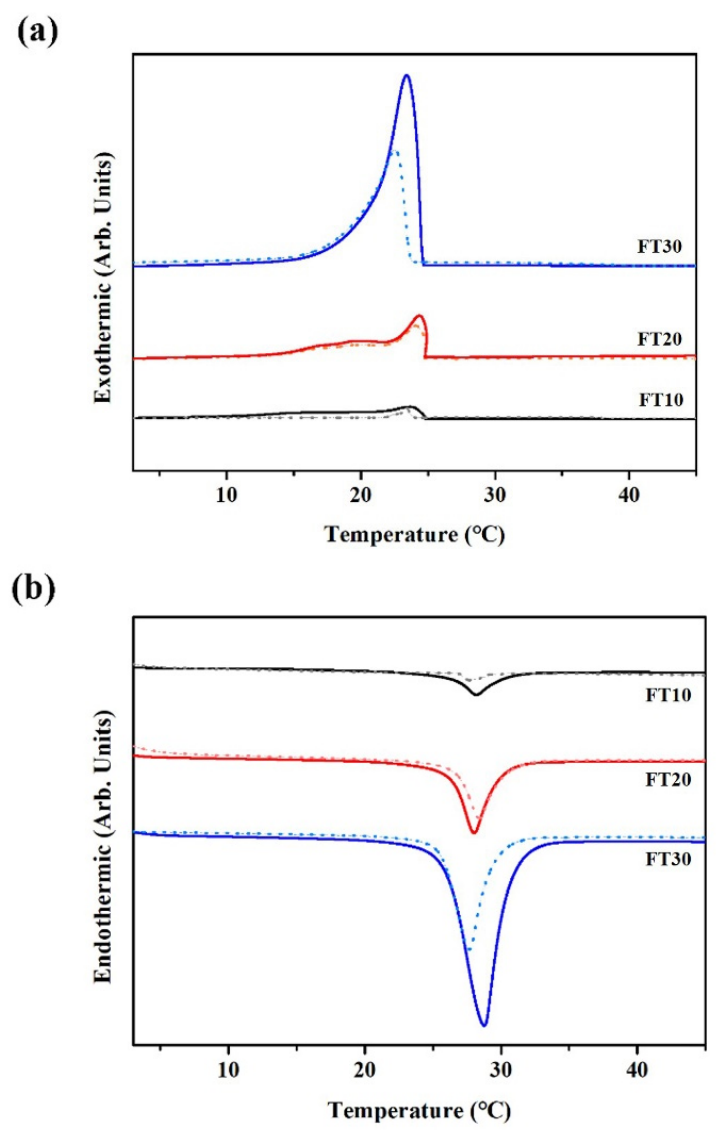
Figure 9. DSC curves of functional textile during ( a ) cooling and ( b ) heating processes. (Solid curves represent functional textile before washed cycles. Dashed curves represent functional textile after 10 washed cycles).